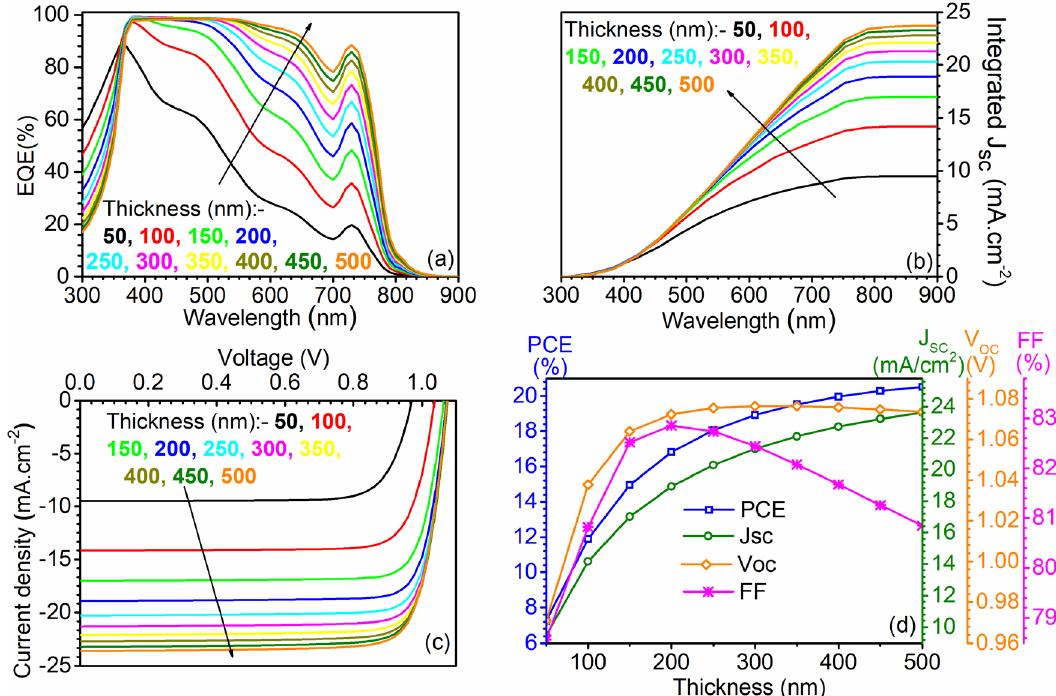
Figure 4. Impact of perovskite absorber layer thickness on ( a ) EQE, ( b ) integrated J SC , ( c ) illuminated J–V curve, and ( d ) PV parameters at various thicknesses, i.e., from 50 to 500 nm. Data reported in figures are obtained from the SCAPS-1D